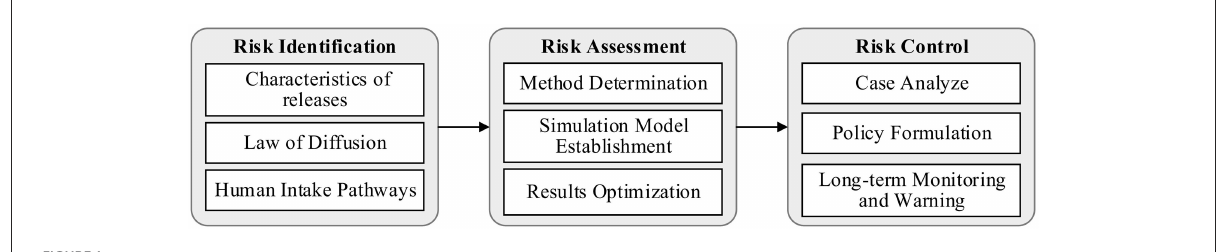
FIGURE1 Life cycle risk management evaluation theory concept